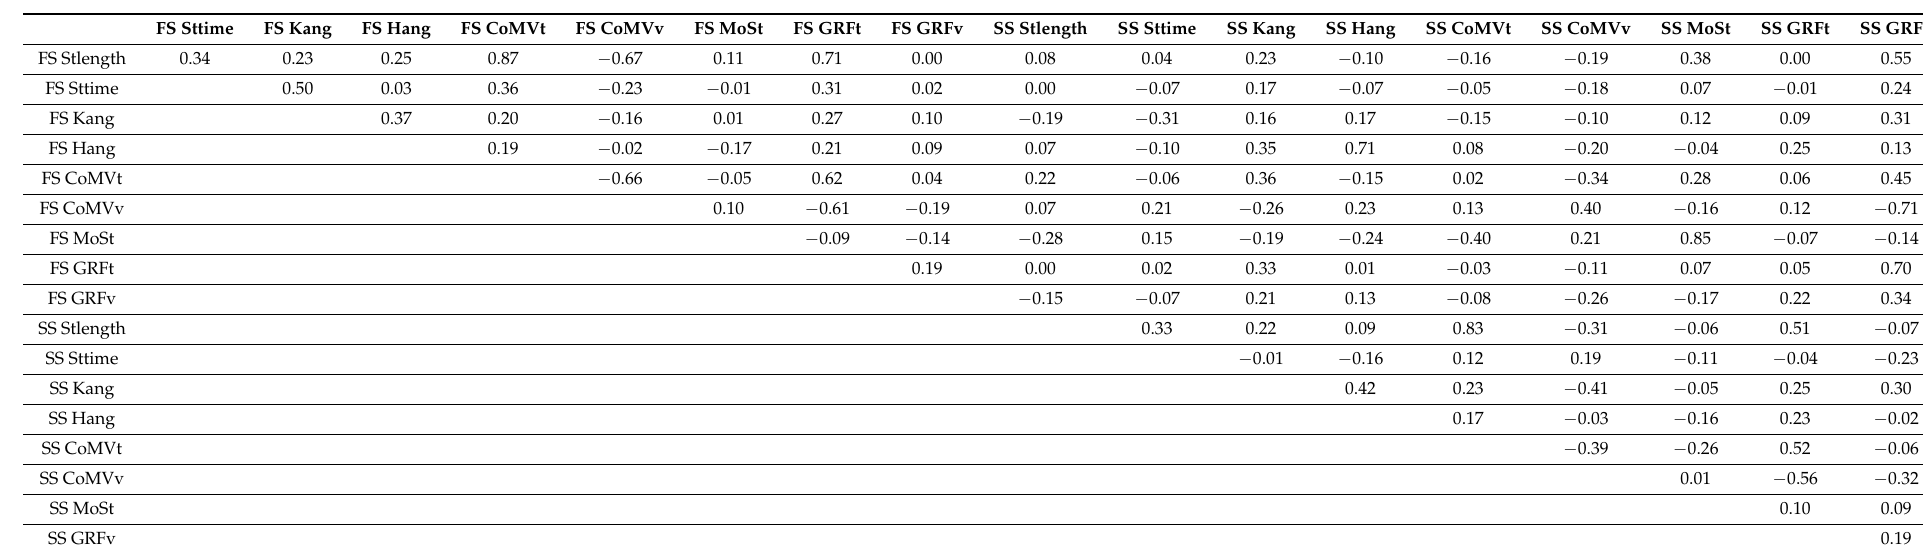
Table 3. Correlations between recovery motion